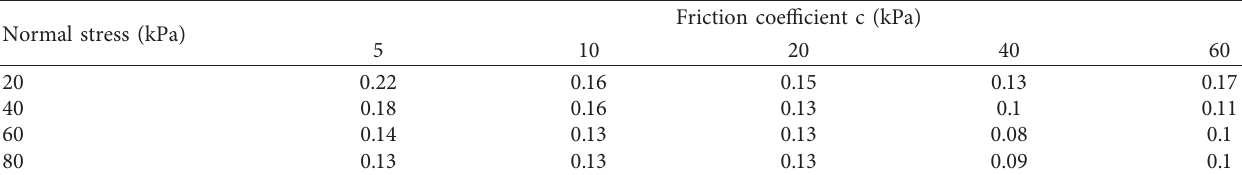
Table 4: Interfacial friction coefficient under different normal stresses.